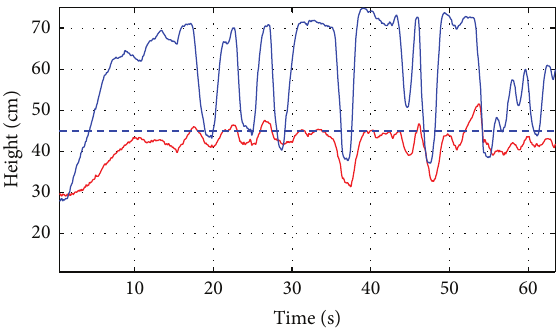
Figure 9: Sample hand heights for the haptic condition: solid blue line is the leader’s hand position and solid red line is the follower’s hand